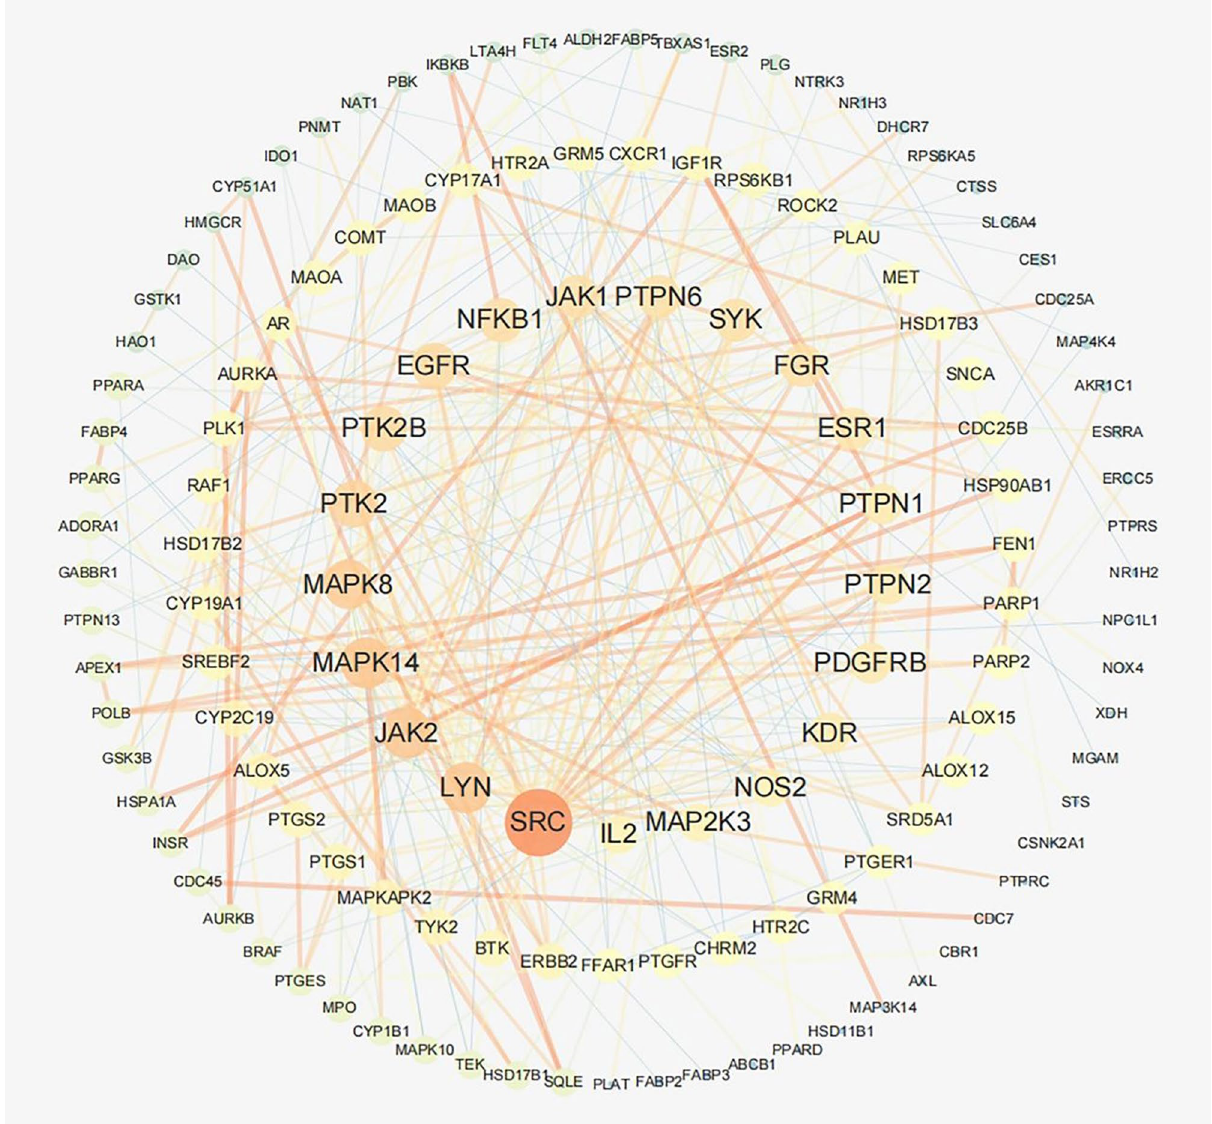
Figure 3. Visualization analysis of the target PPI